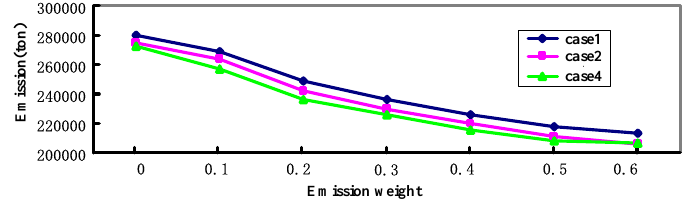
Figure 5. The emission with PHEVs in different cases.